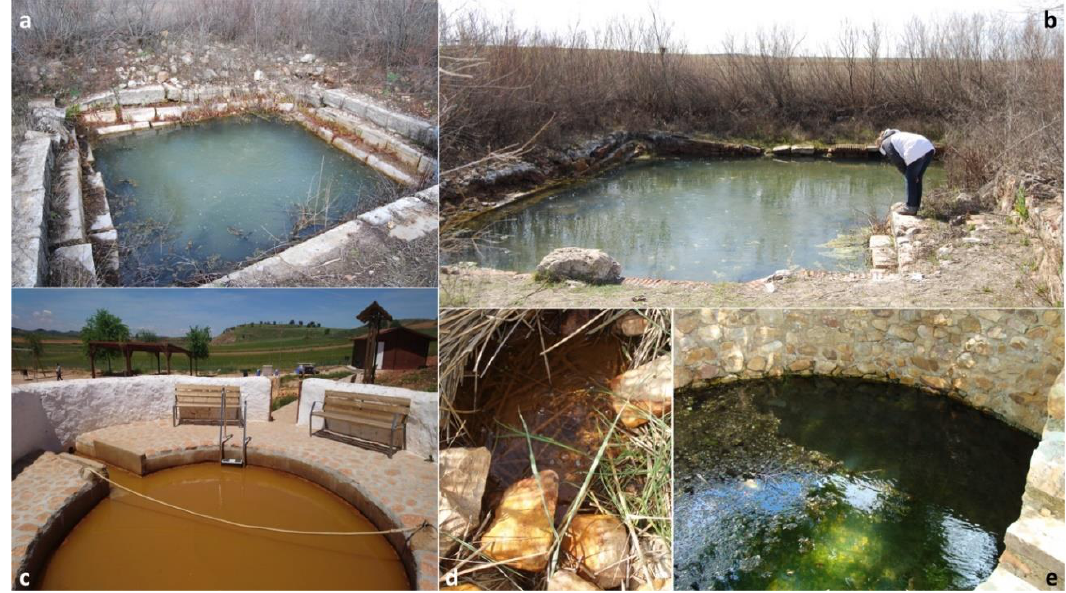
Figure 7. Examples of hot springs and natural spas: ( a ) Baños del Emperador—women’s bath (Miguelturra); ( b ) Baños del Emperador—men’s bath (Miguelturra); ( c ) El Barranco baths (Aldea del Rey); ( d ) Boiling waters in El Barranco (Aldea del Rey); ( e ) El Chorrillo bath (Pozuelo de Calatrava).